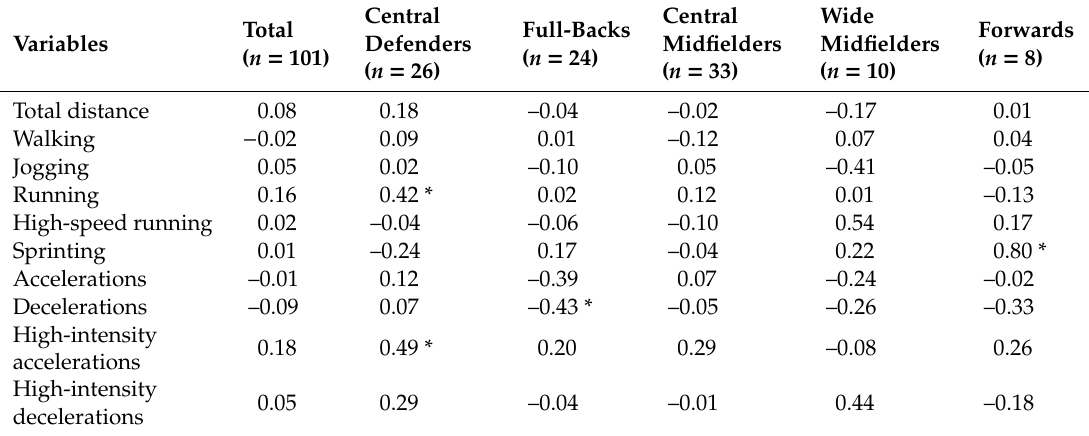
Table 4. Pearson’s product moment correlations between running performances and game performance indicator (InStat) for di ff erent playing